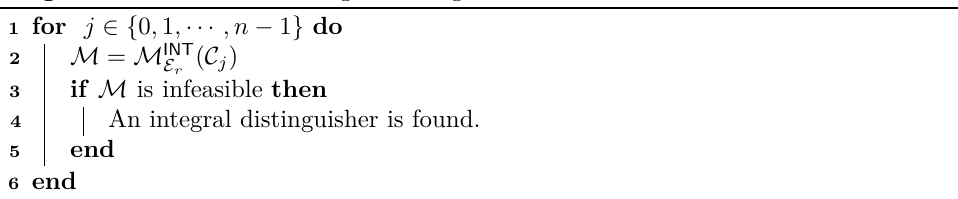
Algorithm 2: Search for integral distinguishers of r -round E